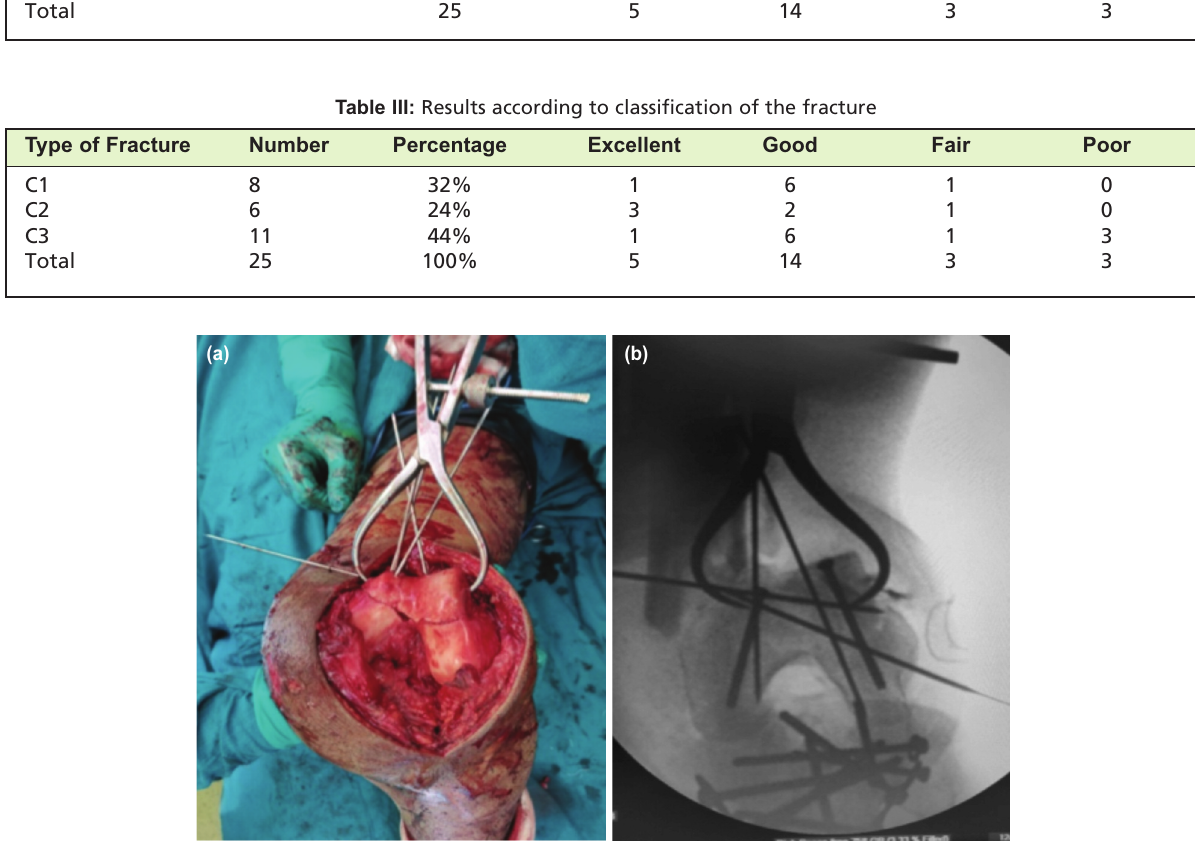
(a) Provisional fixation, (b) C arm image of the same inter-condylar fragment with K wires and clamp and Fig. 1: